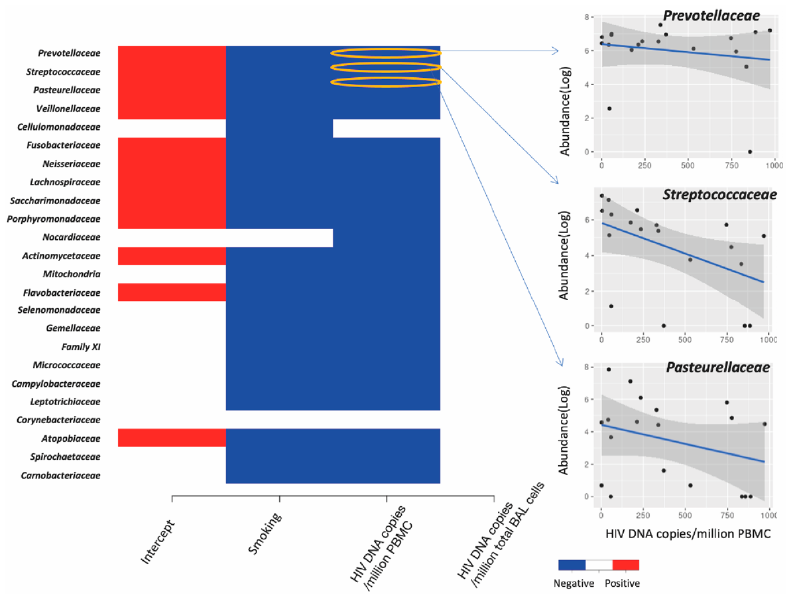
Figure 9. Effect of coefficients of HIV-DNA levels in PBMC and BAL on the abundance of lung bacterial families. Each row represents a bacterial family, and the column represents the HIV-DNA levels. A significant correlation supported by at least 95% posterior probability was depicted in